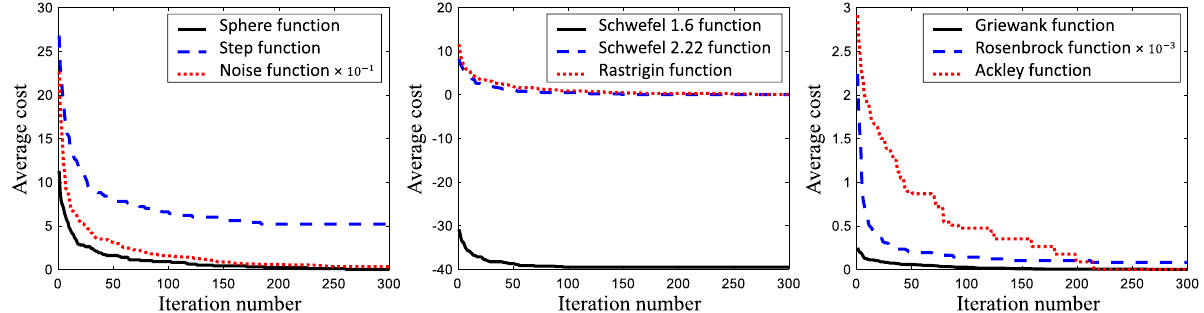
Figure 10. Benchmark function averaged values for 10 independent execution of a 40-particle swarm population with 20 parameters and 300